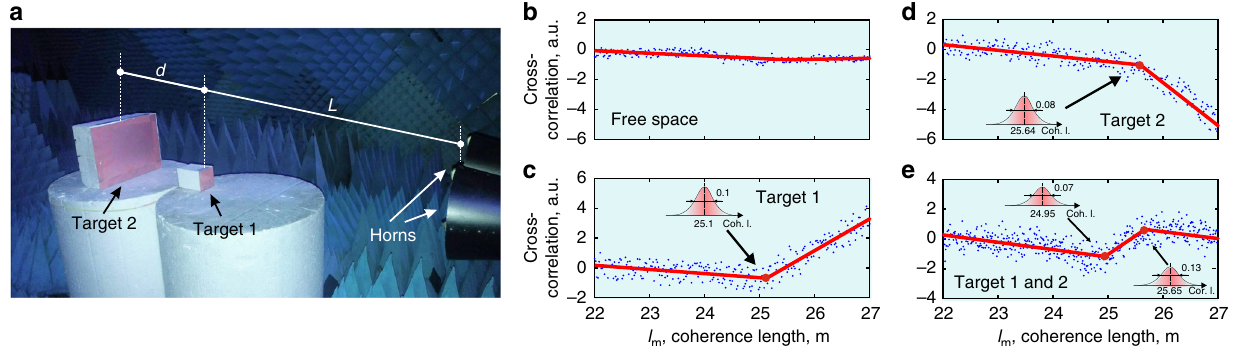
Fig. 5 Detection and separation of two objects with narrowband signals — more than an order of magnitude below standard limitations. a Photograph of the experimental layout where two square plates were placed at a separation of 32 cm away from each other. b – e Plots of cross-correlation as a function of the coherence length. Experimental data — blue points, piece-wise linear fi t — red solid lines. Insets — uncertainty in target locations. b Free space scan — empty room. c , d Single targets without the presence of the other, in accordance with the theoretical plot in Fig. 3b. e Both targets present at the same locations as before. The measured distance between the targets is 35 cm, and it is close to the actual physical value (32 cm) . The correlation length in b – d includes the physical distance to targets (as seen in ( a )) as well as added distance due to cables and delays in other electronic